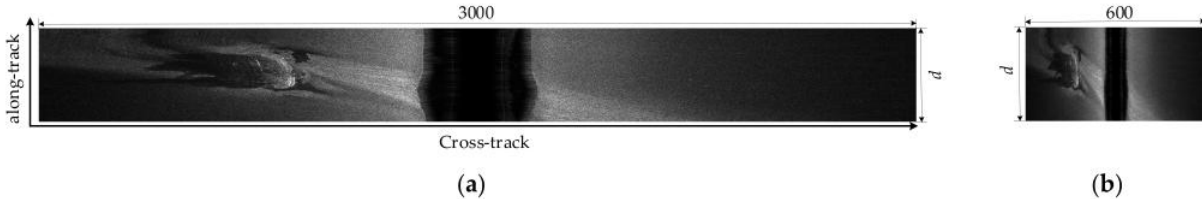
Figure 4. Raw image and the resampled image. ( a ) Raw SSS image of which the mapping resolution is 0.5 m in the along-track direction and 0.1 m in the cross-track direction. It means that the actual distance between two adjacent pixels in the along-track is 0.5 m and 0.1 m in the cross-track direction. ( b ) The sampled SSS image of which the mapping resolution is 0.1 m both in the along-track and cross-track direction.